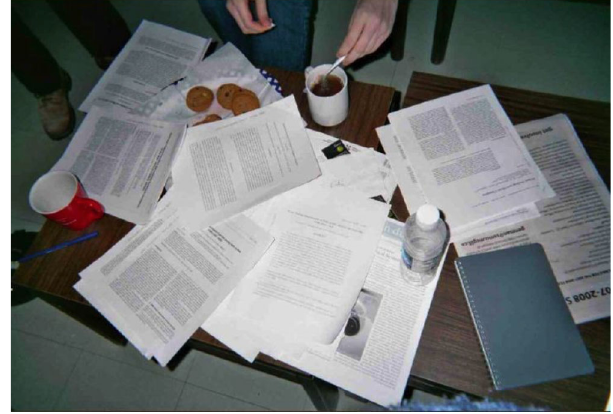
FIG. 1. Molly ’ s photograph of the seminar room during a Cosmic Coffee